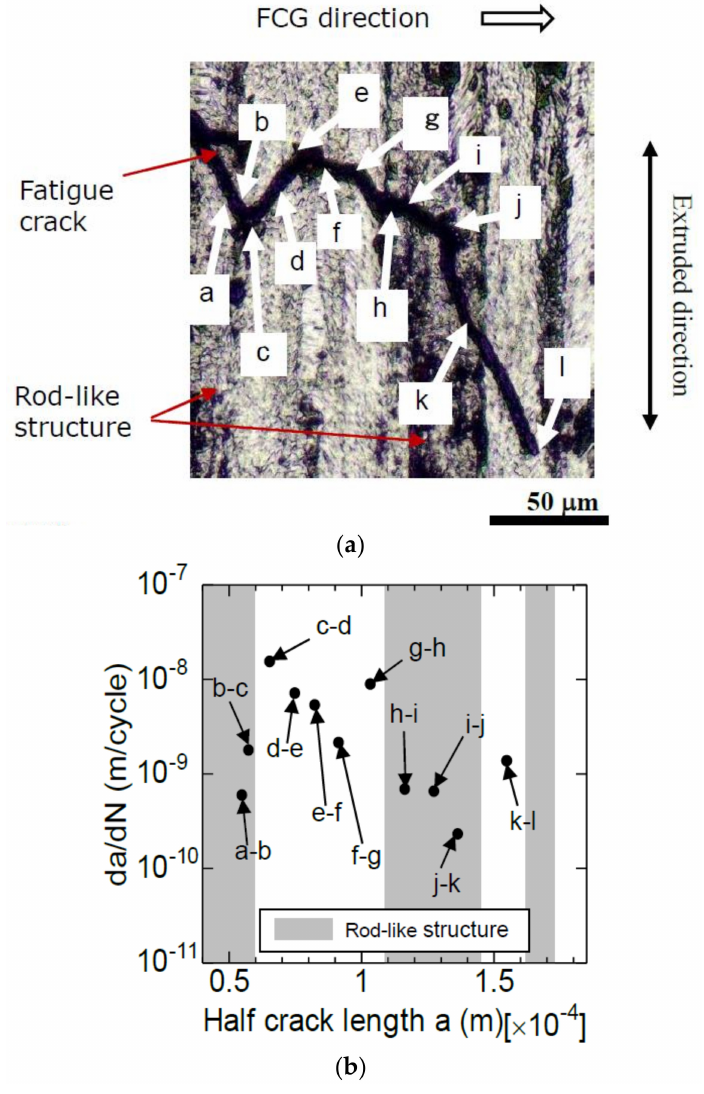
√ m) test (specimen P). ( a ) Rod-like structure;